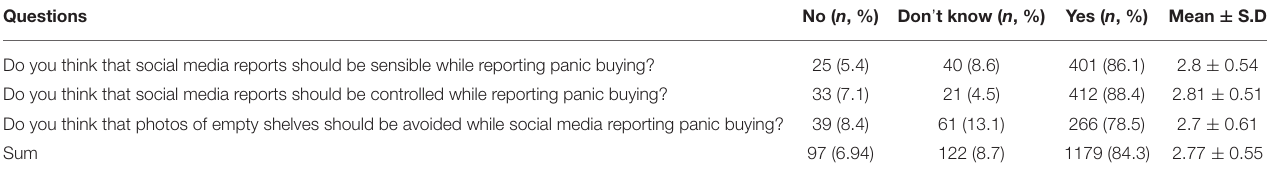
TABLE 4 | Preventive aspects of panic buying on social media. Questions